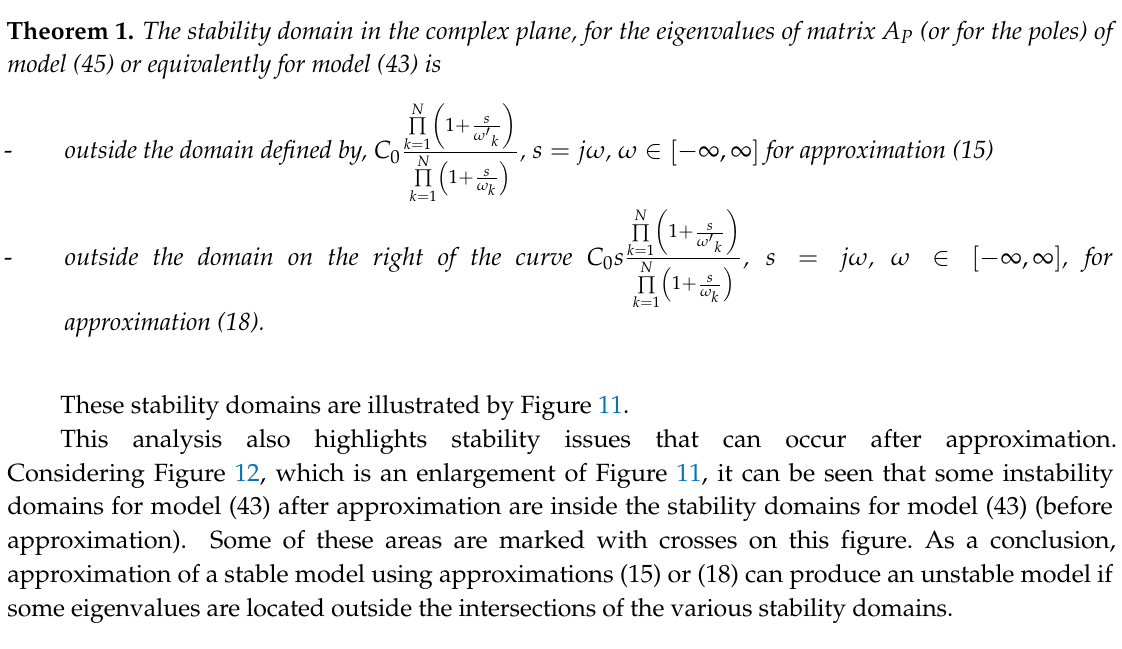
 on a zoom V →  i V λ on a zoom ( left ), i